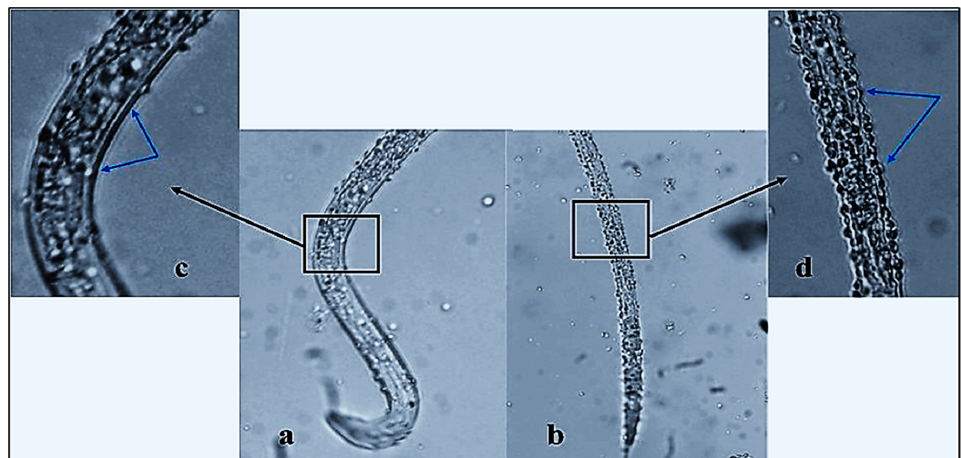
Figure 7. The percentages of deaths induced by ZnO ‐ NPs after 24, 48 and 72 h of treatment; highly significant activity determined by the Tukey pairwise comparison test ( p 0.05). letter “A” represent non sifnificance among control samples; ‘B” represent non significance among base fluid samples; “C & CD” represent the significance between ZnO ‐ NPs at time 24, 48 and 72 h. the highly significant activity was denoted with the letter ”D”.